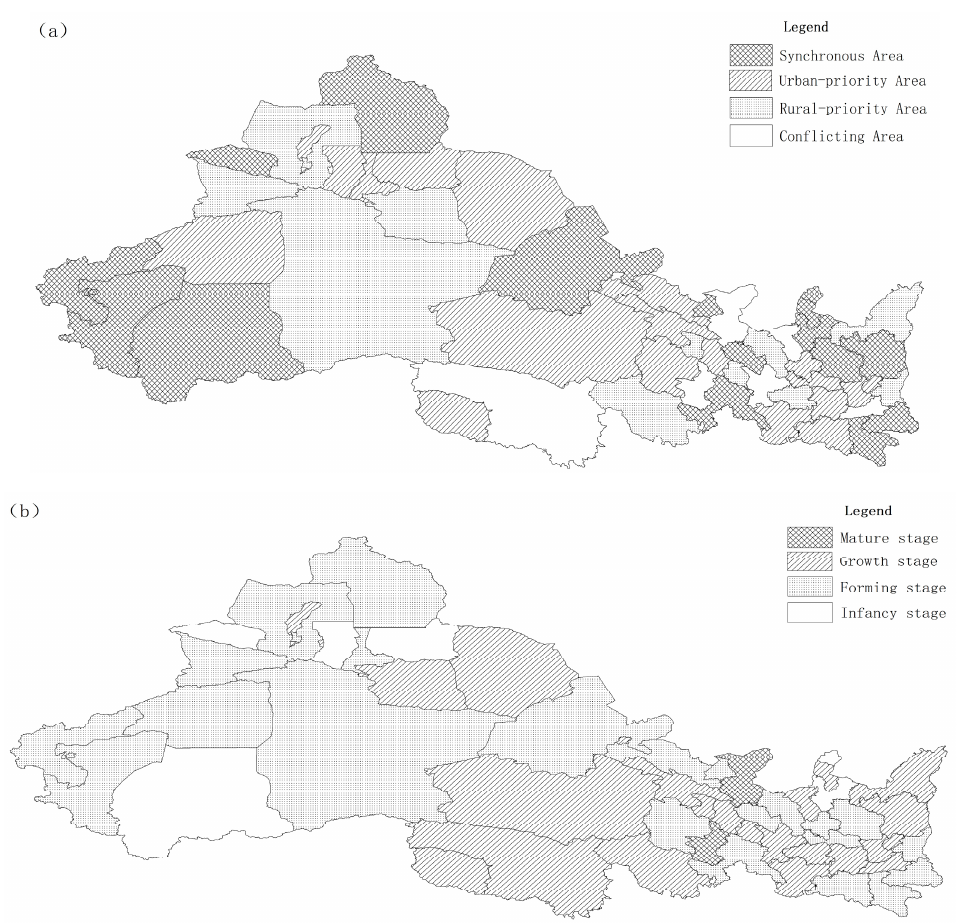
Figure 5. The symbiosis types ( a ) and stages ( b ) of urban and rural water poverty in northwest China.